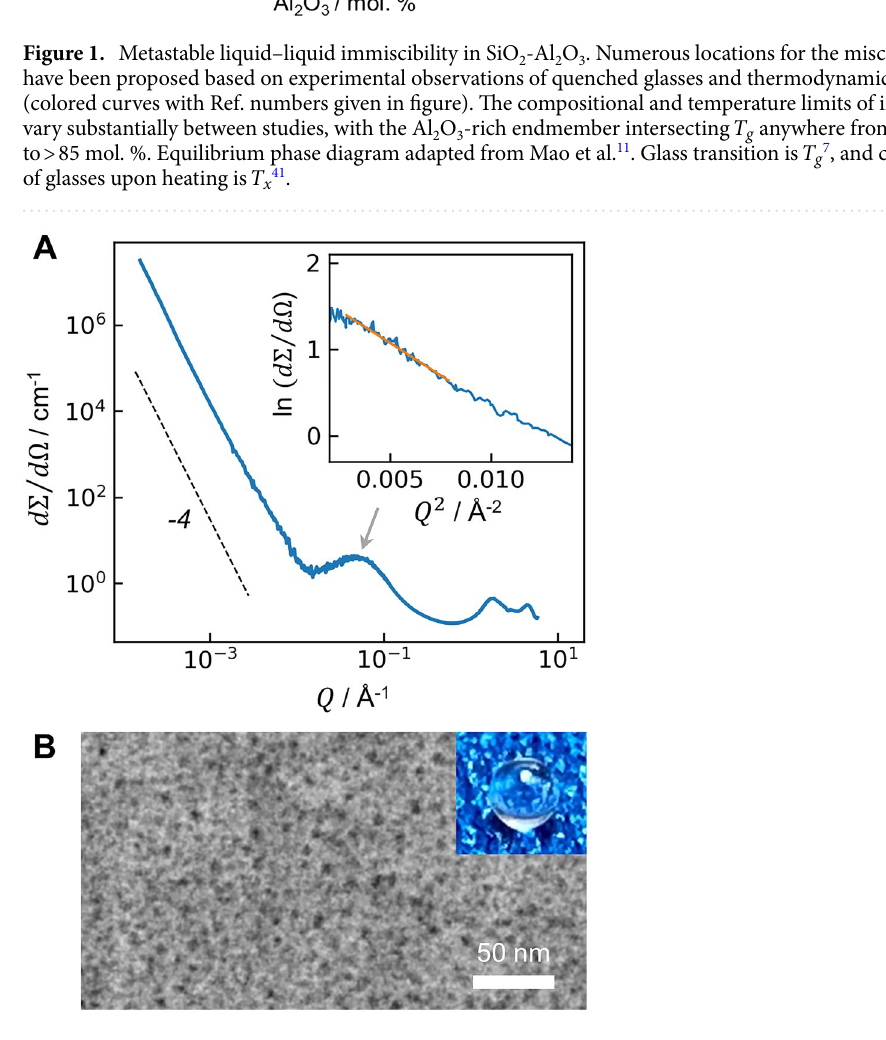
Figure 2. Phase separation in mullite-composition glass. ( A ) X-ray scattering differential cross section exhibits a Porod slope to the right of a small-angle peak near 0.05 Å −1 (gray arrow), indicative of phase-separated domains. Inset: Guinier analysis predicts an average domain size of 5.5 nm. ( B ) High-angle annular dark field STEM image of a 40–100 nm thick mullite-composition glass specimen, revealing contrast between the 4–6 nm Si-rich domains (black) and surrounding Al-rich matrix. Inset: transparent glass bead, 1.3 mm in